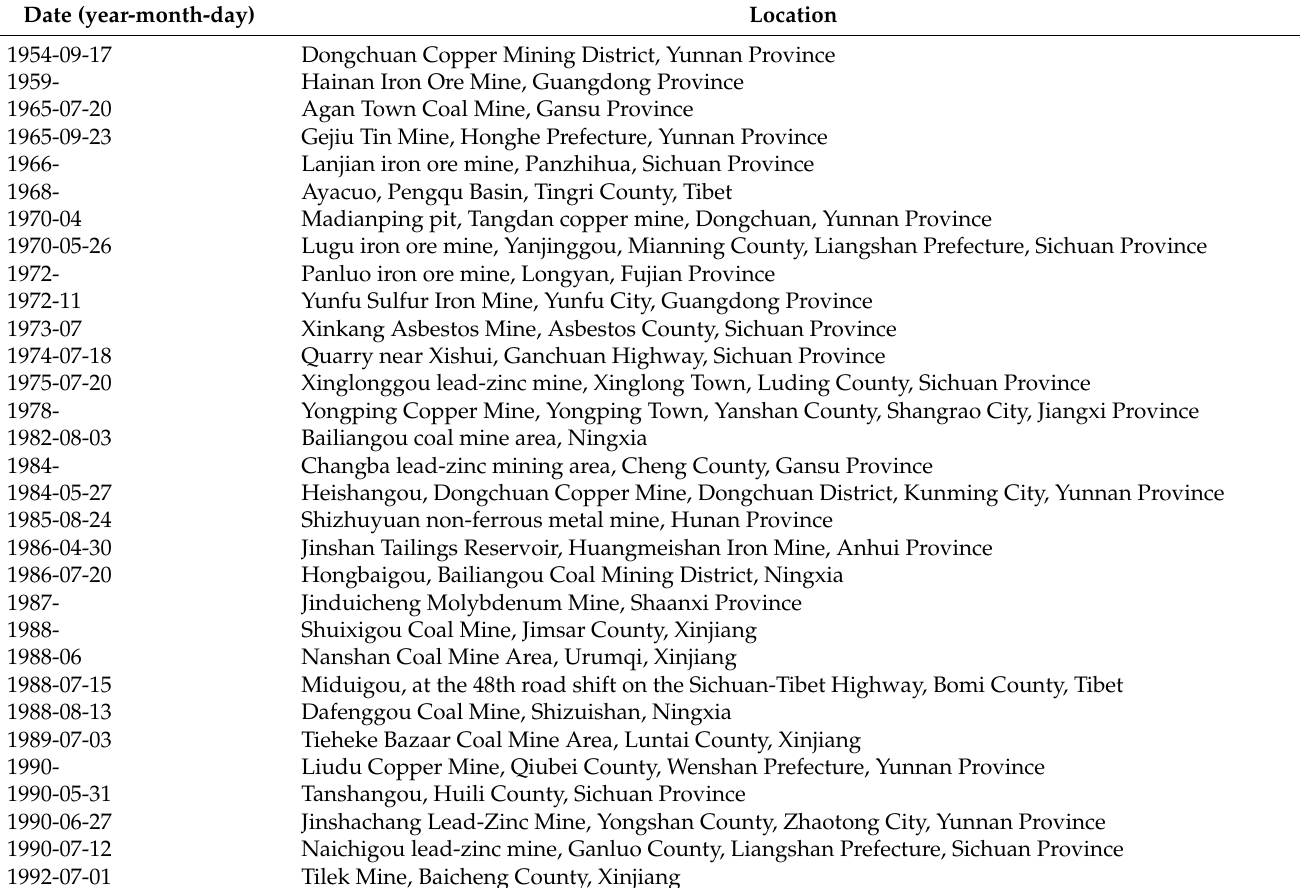
Table 1. Selected major mine debris flow disasters in 1954–2020 in